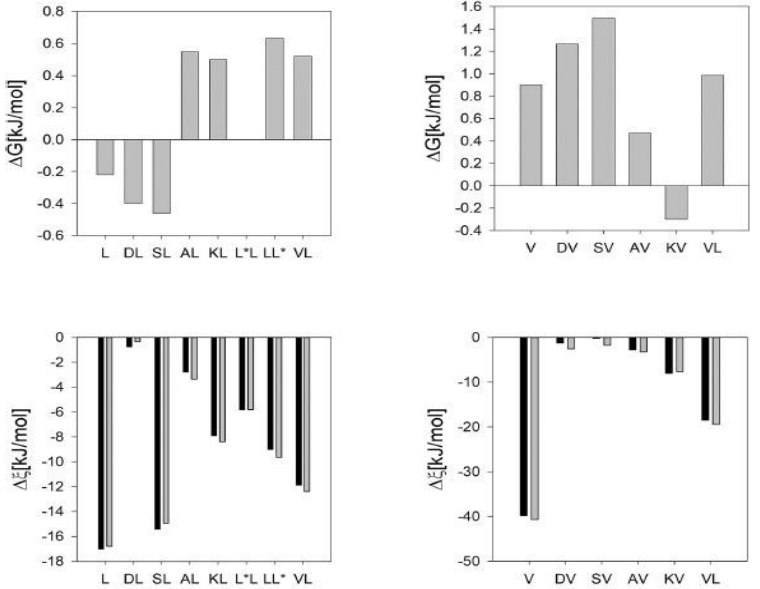
Figure 17. Plots of the Gibbs free energy, enthalpy and entropic contribution to the pPII-β strand equilibrium of aspartic acid, serine ( upper panel ), leucine and valine ( lower panel ) in the presence of indicated neighbors in GxyG tetrapeptides. In the lower panel the character ξ represents ΔH (black) and TΔS (grey). These figure merges two different figures from [99].